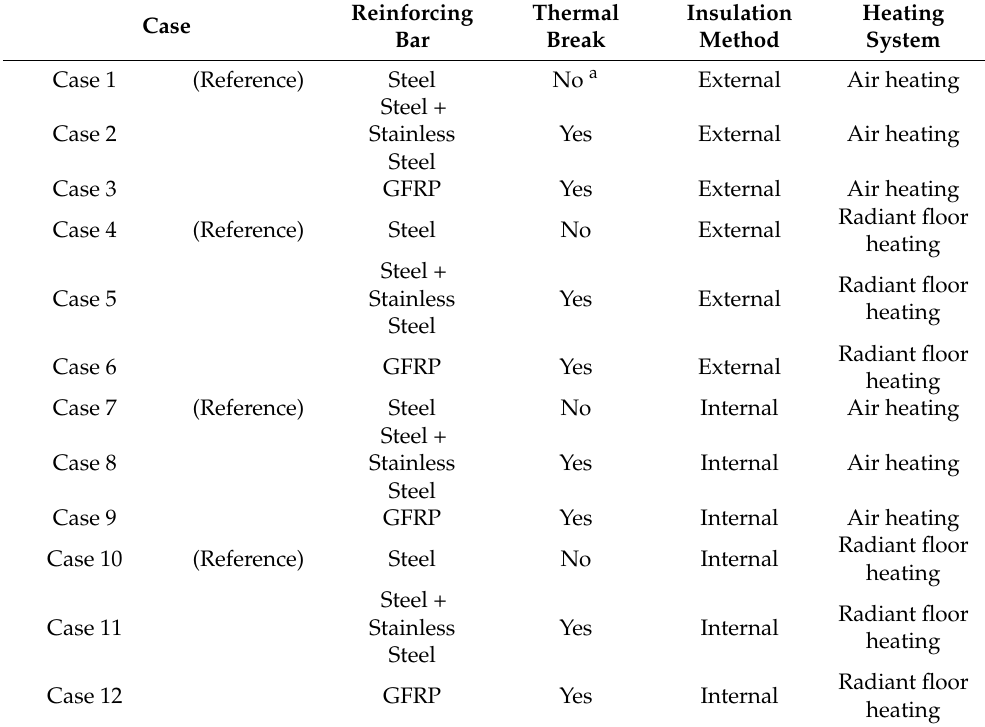
Table 3. Simulation